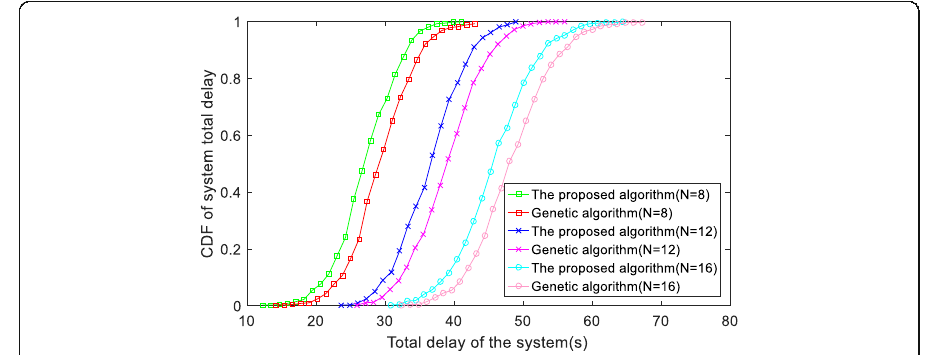
Fig. 9 CDF curve of a system delay with a different number of